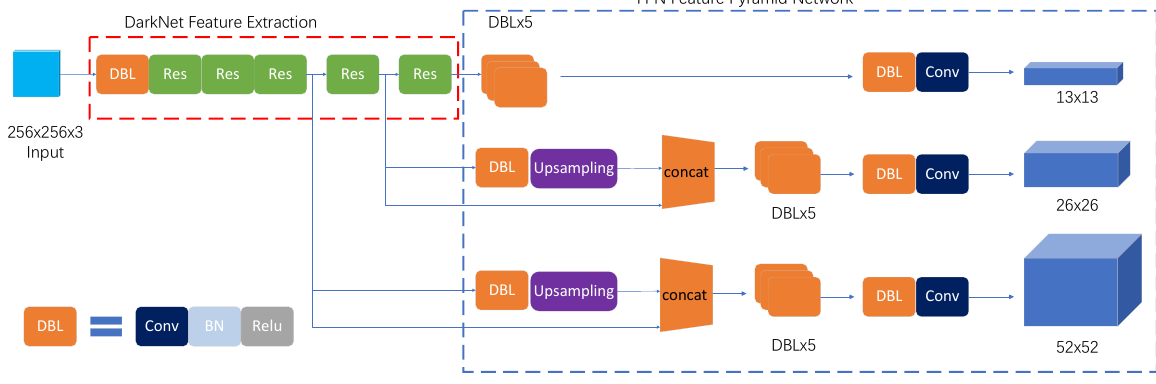
Figure 4. The Yolo model.